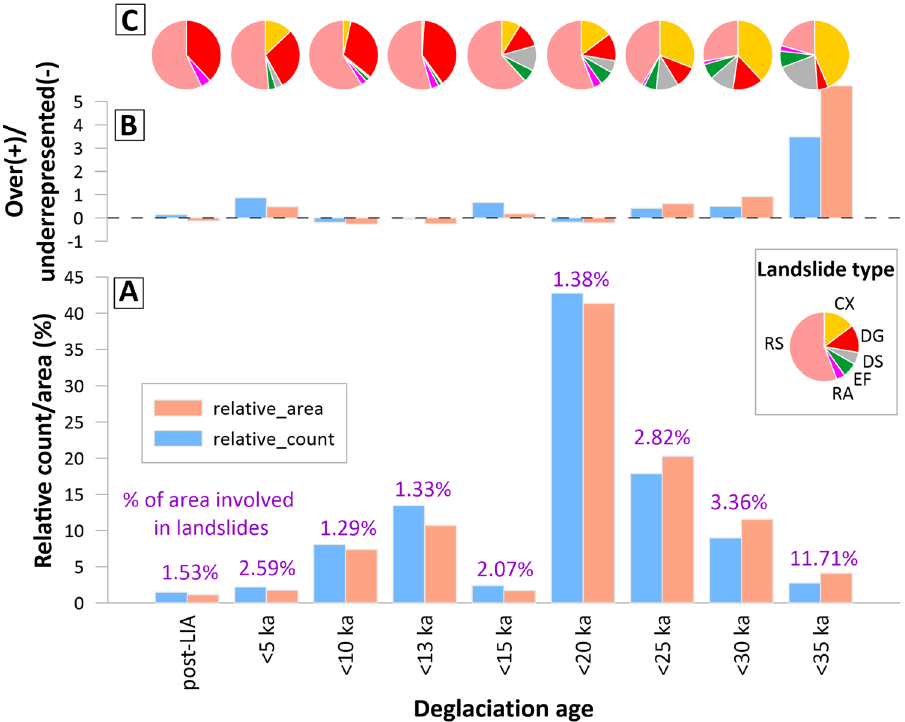
Figure 4. Distribution of large landslides in regions with different ages of deglaciation. ( A ) Bar plot of the large landslide relative area/count in the deglaciation period. Number above histograms illustrates percentage of the area which is affected by large landslides. ( B ) Quantification of landslide over/under-representation. Negative values suggest an under-representation of the landslides while positive values suggest an over-representation of landslides in landscape strips with different ages of deglaciation. ( C ) Proportion of landslide types in regions with different ages of deglaciation. The presence of landslides in distinct deglaciated areas approximates their maximum age. Note the considerable increase in large landslide area and number in landscape strips which were deglaciated ≥ 20 ka, coinciding with an increase in the proportion of volcanic and weak sedimentary rocks. The ages of deglaciation are after Davies et al. 22